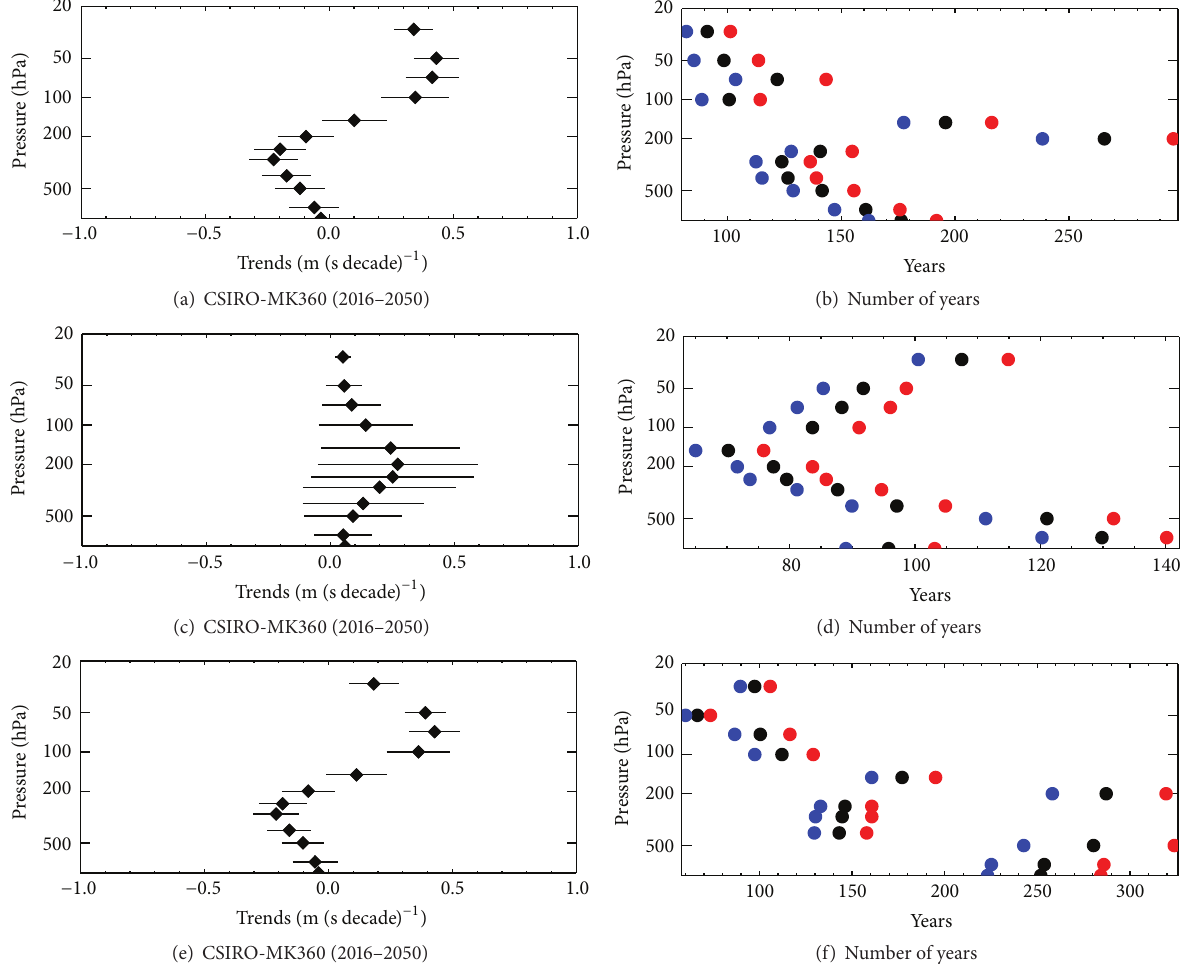
Figure 9: Future estimated trends and numbers of years for zonal wind (a, b), meridional wind (c, d), and wind speed (e, f), respectively. Black diamond symbol represents the ensemble mean trends calculated by averaging trends found from individual 10 ensemble member. Horizontal black thin line in (a), (c), and (e) represents 1-sigma trend uncertainty. Circle symbols represent number of years (black filled circle represents the mean, blue the minimum, and red the maximum). Note that the blue circles and red circles in (b), (d), and (f) represent the 95% confidence interval for the number of years which is represented by black